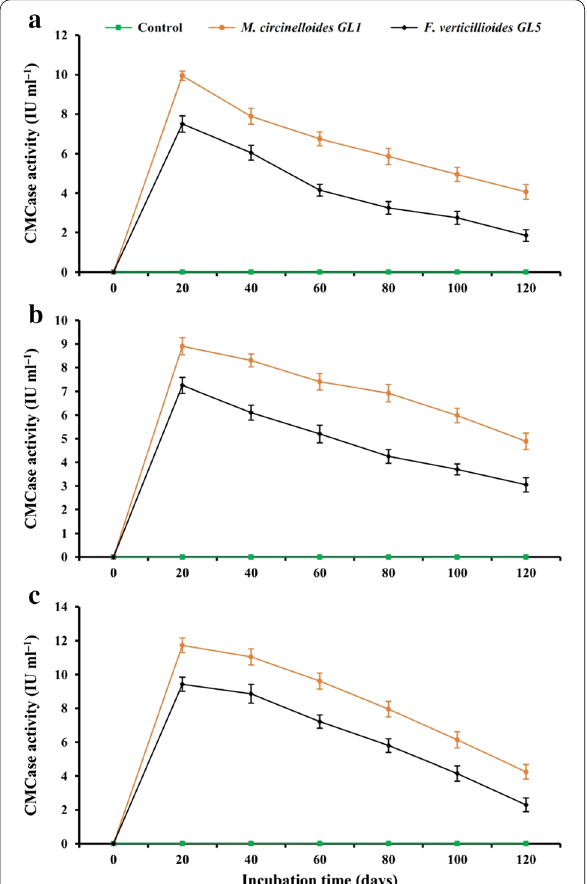
Fig. 3 Changes in ligninolytic enzyme activity of paddy straw treated with ligninolytic fungi during solid-state fermentation in different time intervals. a laccase, b MnP and c LiP